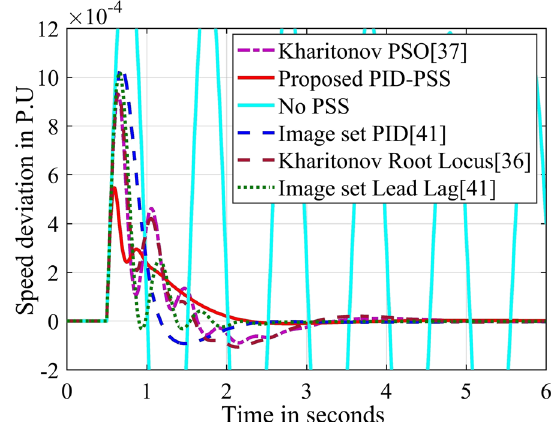
Fig. 15 Comparision of speed deviation response of the proposed with existing methods to 0.1 p.u. torque disturbance at P = 0.8 p.u. and Q = 0.3 p.u